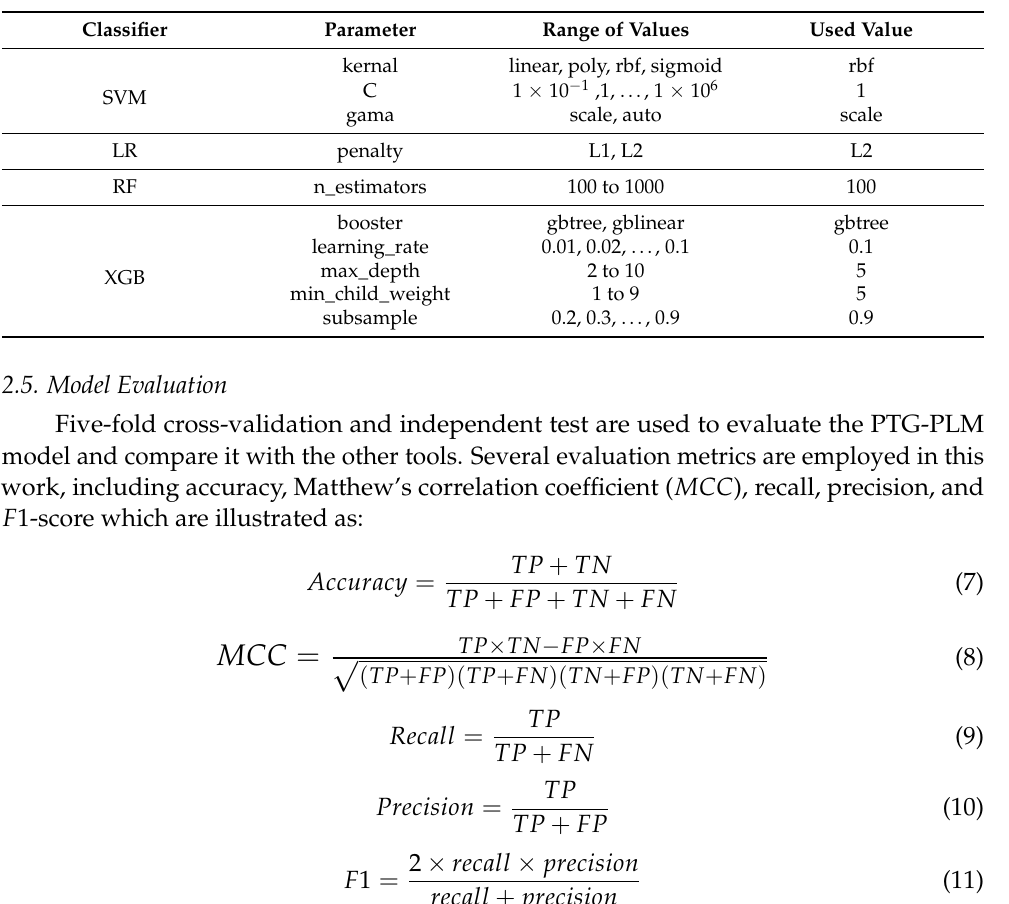
Table 4. Hyperparameters setting for the used machine learning classifiers and the used value for each